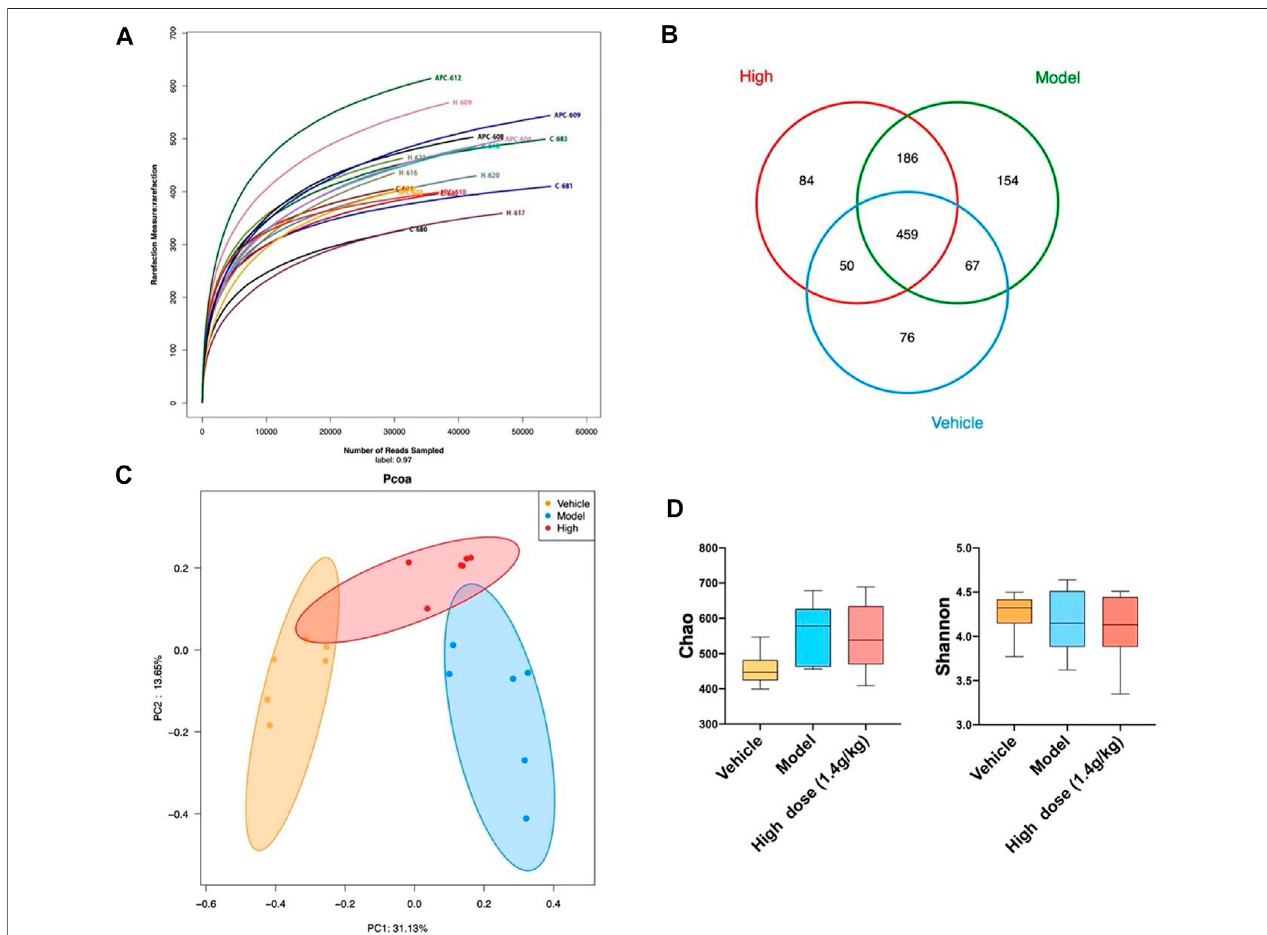
FIGURE 6 | QCWZD can change the structure of intestinal microbiota in Apc min/+ mice. (A) Rarefaction curves determined at the 97% similarity level. (B) Venn diagram of OTUs in the three groups (vehicle group, model group, high-dose group). (C) Multiple-sample PCoA analysis. (D) Chao and Shannon indices. High dose: 1.4